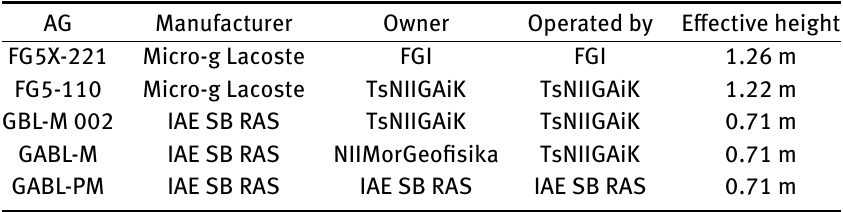
Table 1: The participating AGs. The gravimeters were operated by the authors of this paper. The effective height [4] depends, not only on gravimeter construction, but also on which interference fringes are used, and on the marker height above the mounting surface. It also varies from setup to setup. Here a nominal value above a flat mounting surface is given, in the configuration used in the comparison. AG